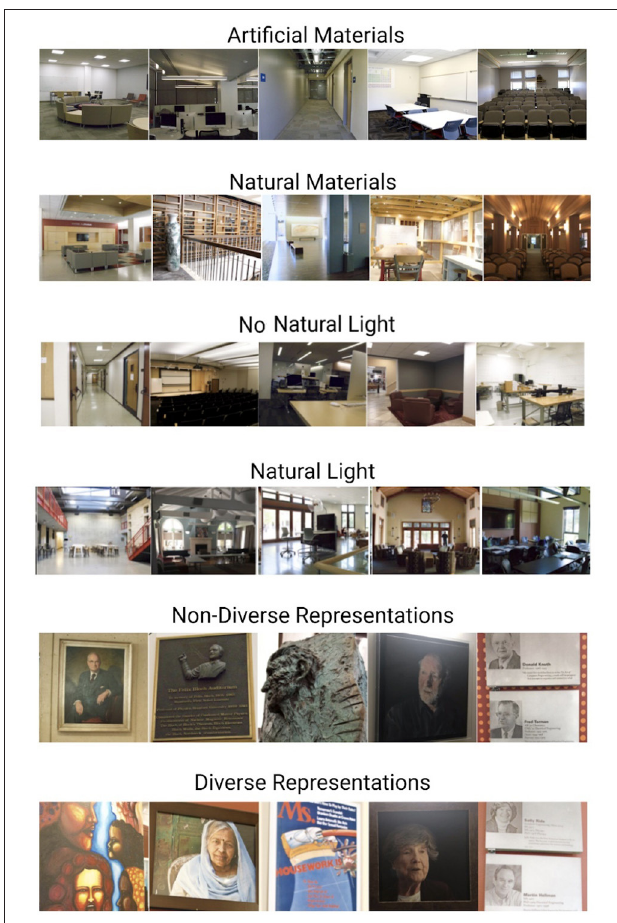
FIGURE 1 | Pictures taken around the lead authors’ university campus used in Studies 1, 2 and 3.